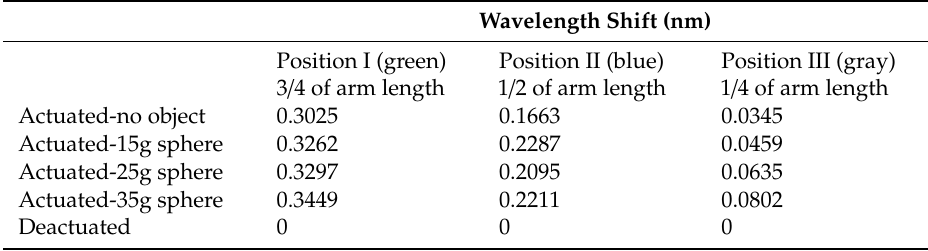
Figure 4. ( a ) Illustration of various FBG embedding positions in the gripper arm (red dotted lines indicate the location of the FBG); ( b ) effect on FBG wavelength shift in optical spectra due to different events occurring at the soft gripper (i) Position I: FBG embedded at 3/4 arm length from the tip, (ii) Position II: FBG embedded at 1/2 arm length from the tip, and (iii) Position III: FBG embedded at 1/4 arm length from the tip. Table 1. Wavelength shift of FBG embedded in three different positions